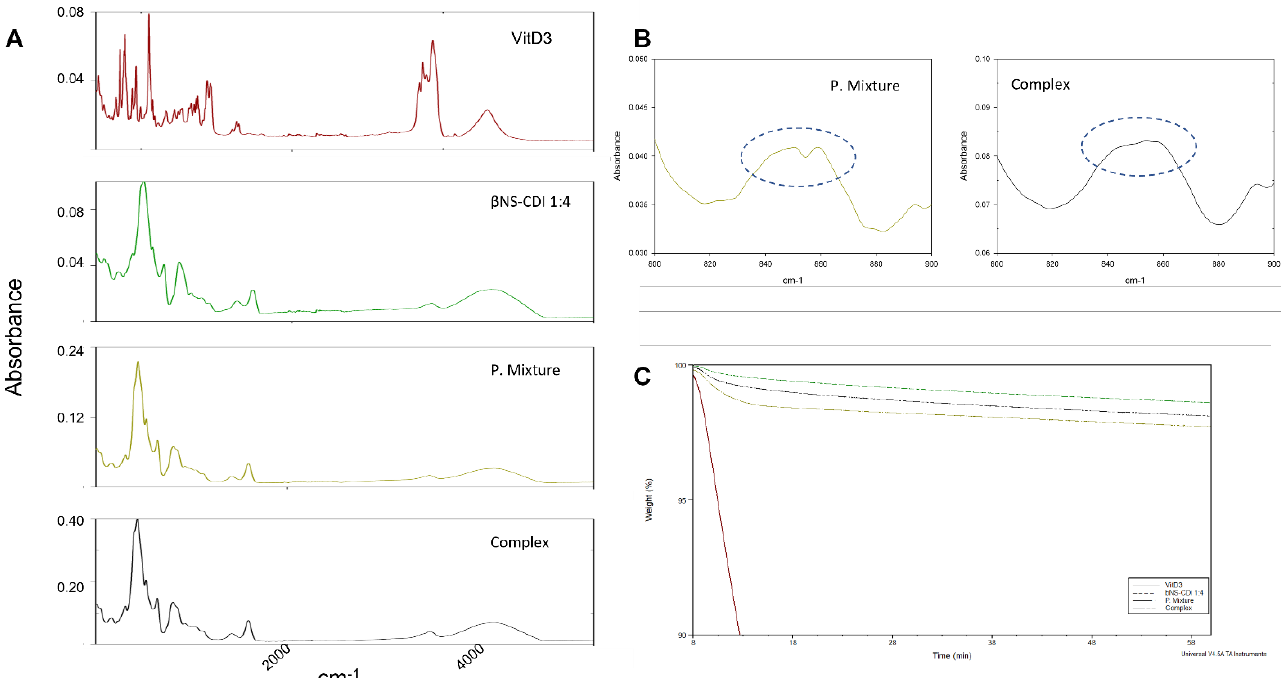
Figure 1. ( A ) FTIR–ATR spectra of VitD3, β NS–CDI (1:4), physical mixture and complex. ( B ) detail of 800–900 cm − 1 spectra, indicated with dotted circle, peaks at 859 and 843 cm − 1 . ( C ) Isothermal TGA of VitD3, βNS– CDI (1:4) (called bNS-CDI 1:4) , physical mixture (P.Mixture) and complex at 200 °C.